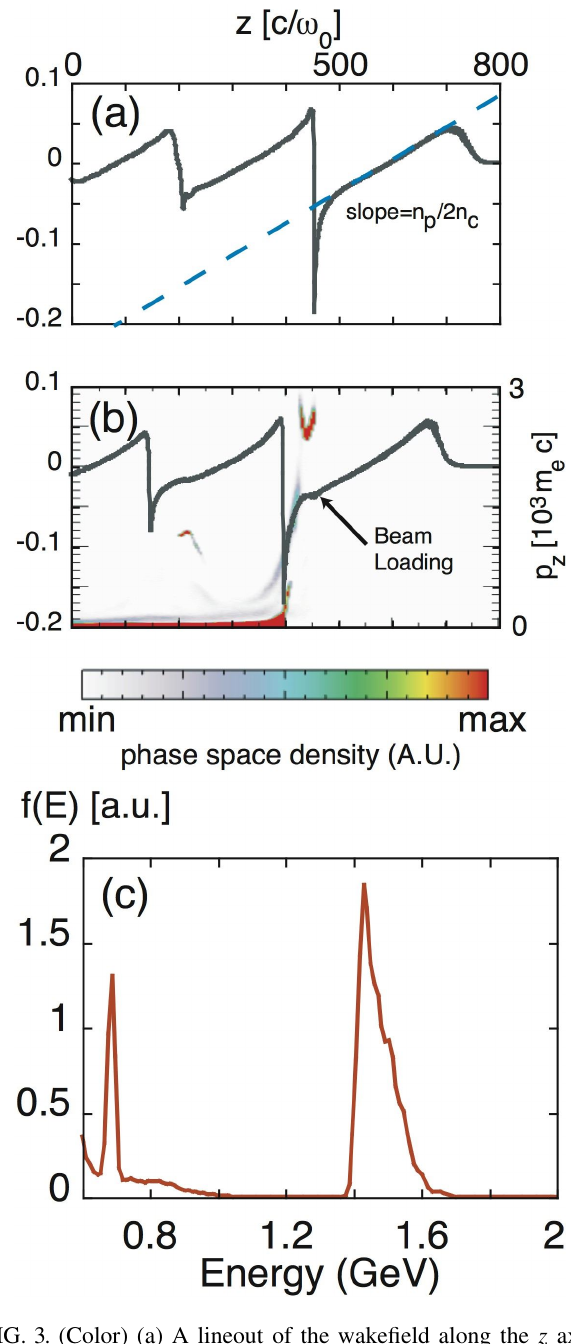
FIG. 3. (Color) (a) A lineout of the wakefield along the z axis after 0.3 mm shows that within the first bucket the slope of the (cid:5) ’ (cid:10)= 2 , = (cid:4) mc! wakefield is nearly constant and equal to eE z p (cid:4) ct (cid:2) z (cid:5)(cid:10) . After 5.7 mm of propagation (b) the where (cid:10) (cid:3) (cid:9) k p wakefield has been modified by beam loading (flattening of the ). This is corroborated by the p vs wake between 400 – 450 c=! p z z plot that is superimposed on the lineout of the wakefield. Panels (a) and (b) reveal that the acceleration mechanism is extremely stable during the simulation. The energy spectrum after 7.5 mm (c) exhibits an isolated spike of 0.3 nC at 1.5 GeV with energy spread (cid:1) (cid:6)=(cid:6) (cid:3) 3 : 8% corresponding to the first bucket and a second spike of 50 pC at 700 MeV with energy spread (cid:1) (cid:6)=(cid:6) (cid:3) 1 : 5% corresponding to the second